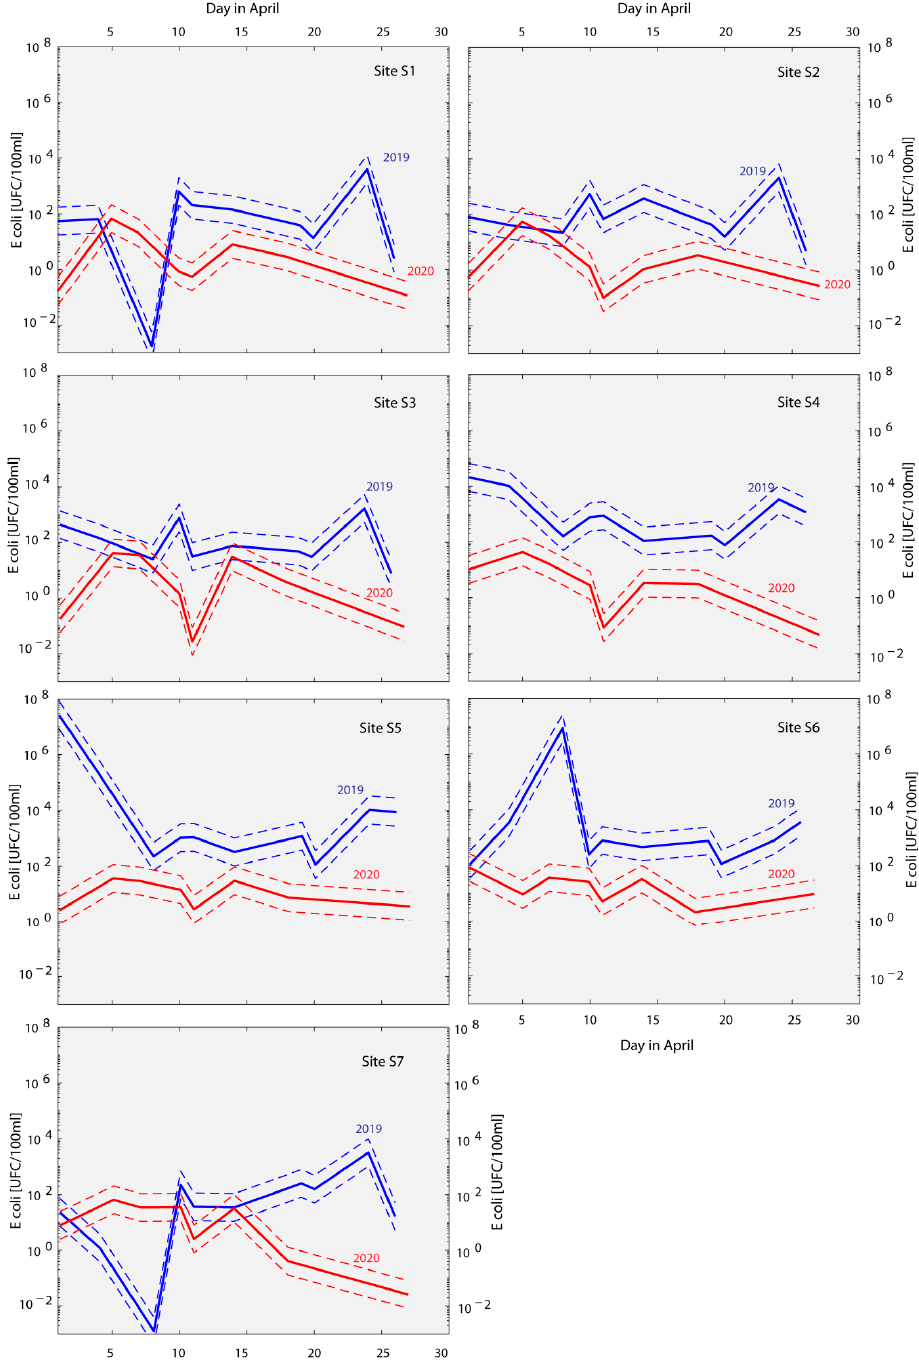
Figure 9. The variation of the E. coli estimated values (note the logarithmic scale) in the west coast of Tangier, northern Morocco, during April 2019 and 2020. The solid lines show the estimated value while the dotted lines mark the root mean square deviation (RMSD) of the linear model (1).